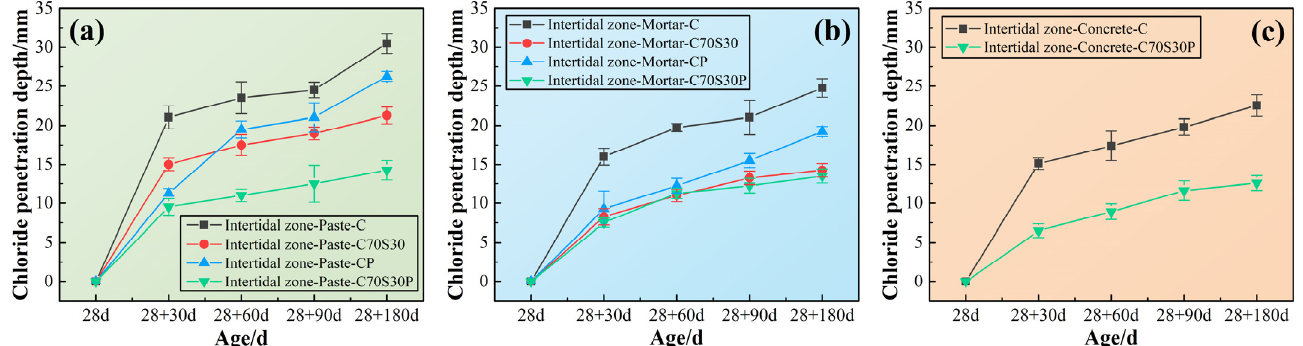
Figure 14. The chloride ions’ penetration depth of CBRM serving in the intertidal zone simulated environment. ( a ) CBRM-Paste, ( b ) CBRM-Mortar, and ( c ) CBRM-Concrete.